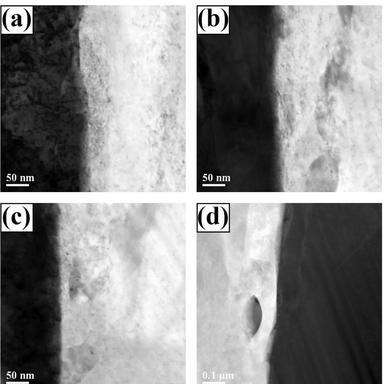
The high-magnification (aec) bright-field and (d) dark-field FIB-TEM images from the interface of Mg-matrix with the Ni-foil layers showing the nature of interface and mechanism of bonding between these two materials during the AFF process.